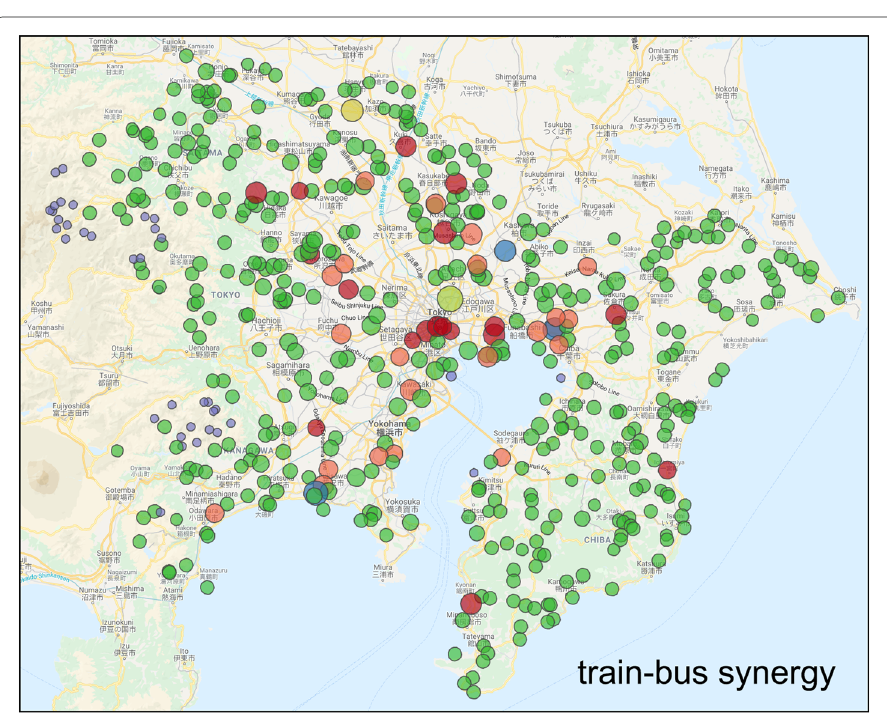
Fig. 12 Public transportation synergy scores (sizes) and groups via hierarchical clustering (colors). Size represents the mean of the four synergy measures, so the small purple dots indicate a score of 0 (no trains, sometimes no buses either). Although the regions of similar synergy levels are scattered geographically, regions of low synergy may indicate areas where increased bus service could substantially increase reachability